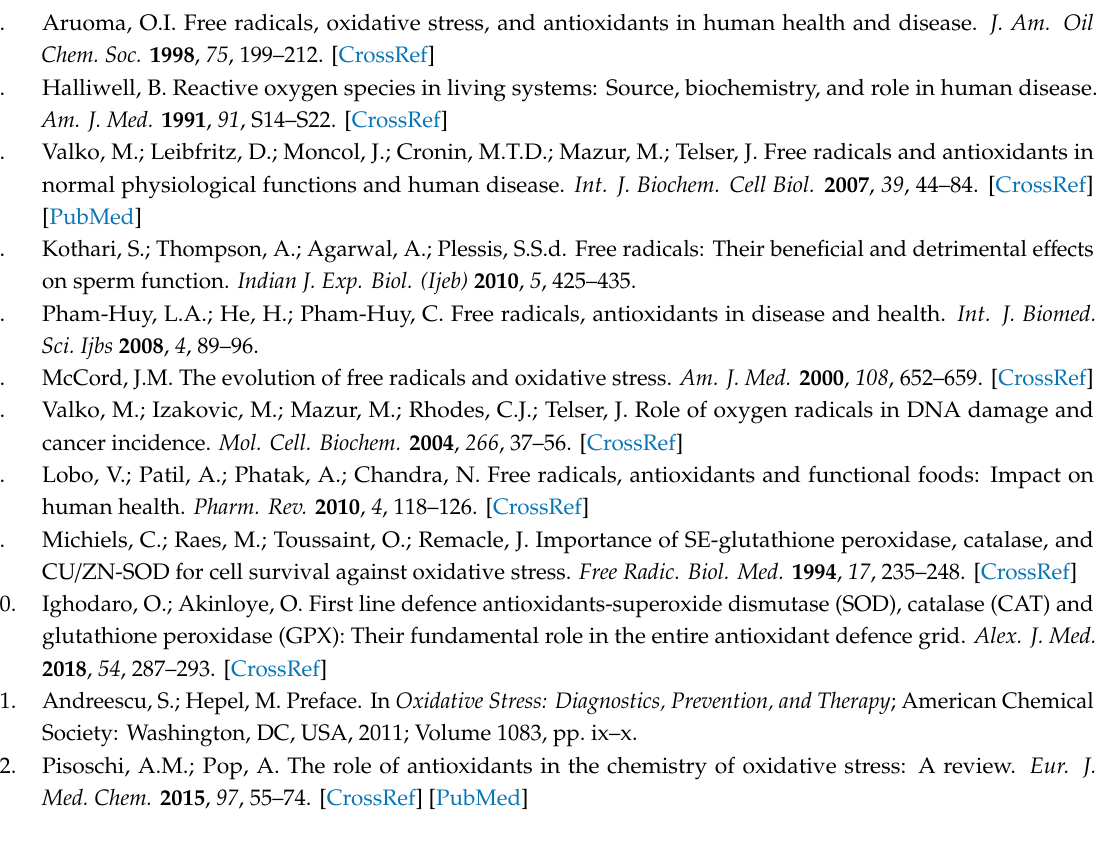
Supplementary Materials: The following are available online, Figure S1: (A)Reaction kinetics of DPPH radical with TSC-1, TSC-4, TSC-5, TSC-6, and Trolox; (B) %DPPH radical remaining at infinite time at the di ff erent concentration of TSC-1, TSC-4, TSC-5, TSC-6 and Trolox, Figure S2: Time kinetics plots of the TSC-1, TSC-4, TSC-5, TSC-6 inhibition of DCFH oxidation by AAPH. (the inset is dose-response plot); Figure S3: Optimized ground state structures and the orbital distribution and energy (eV) of HOMO and LUMO for the studied camphene-based thiosemicarbazone; Figure S4: Calibration curve of DPPH in ethanol at 517 nm; Figure S5~S10: 1H-NMR and 13C-NMR of TSC-1~6; Table S1 Selected bond lengths and dihedral angles of the neutral forms of thiosemicarbazone in ethanol solution Table S2. Selected bond lengths and dihedral angles of the radicals of thiosemicarbazone in ethanol solution; Table S3. Selected bond lengths and dihedral angles of the cations radical of